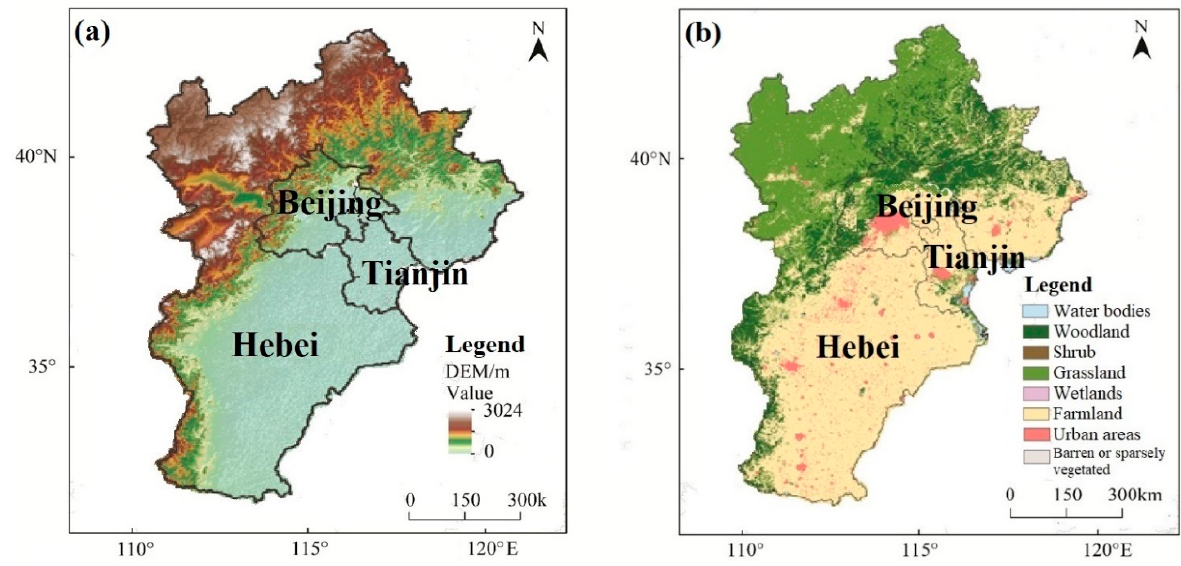
Figure 1. Map of the general situation ( a ) and land cover and land use ( b ) of the study area.